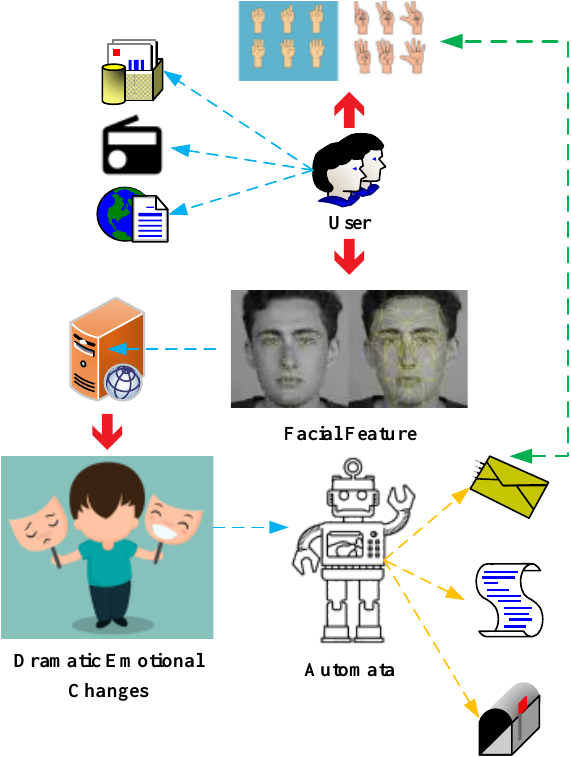
Figure 3. Man – machine voice interaction process . Figure 3. Man–machine voice interaction